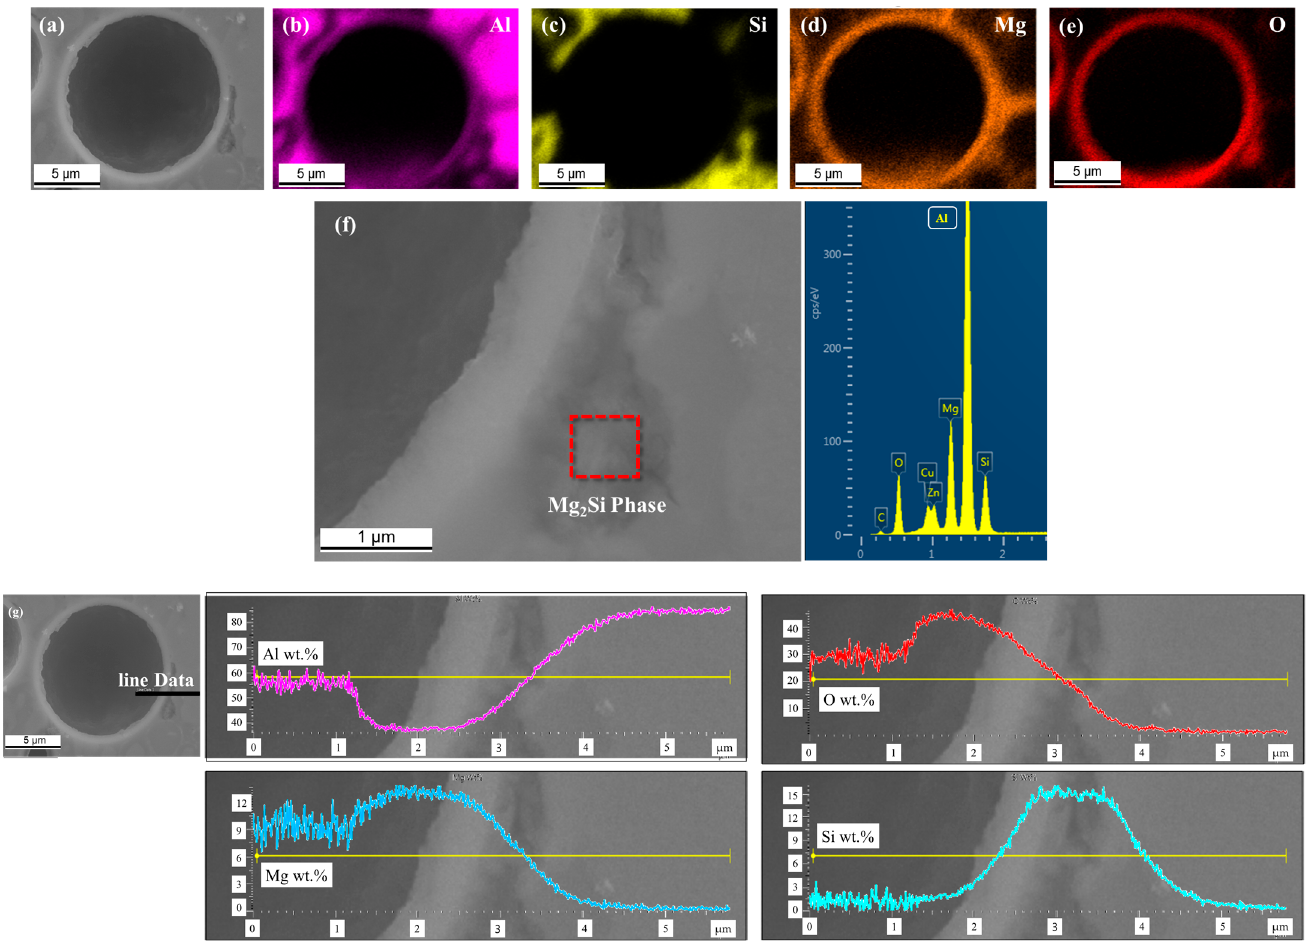
Figure 10. SEM and corresponding EDS results for Al60G10 foam: ( a ) SEM image of GHS; ( b ) Al-k map; ( c ) Si-K map; ( d ) Mg-k map; ( e ) O-k map; ( f ) EDS point profiling around GHS shell; ( g ) EDS line pro fi le image of GHS-matrix interface.